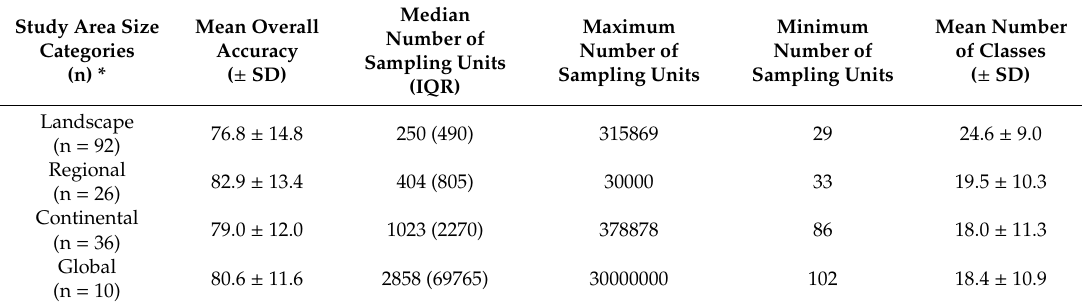
Table 2. Main features extracted grouped by study area size categories.